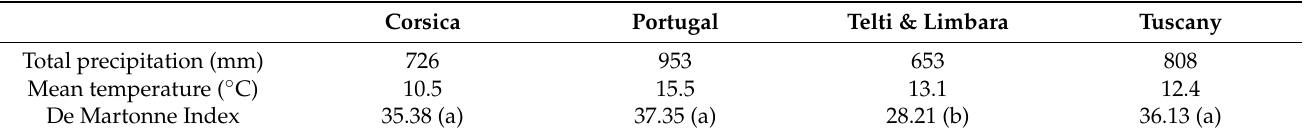
Table 3. Climate data at the locations of origin of the provenances (annual mean for the period